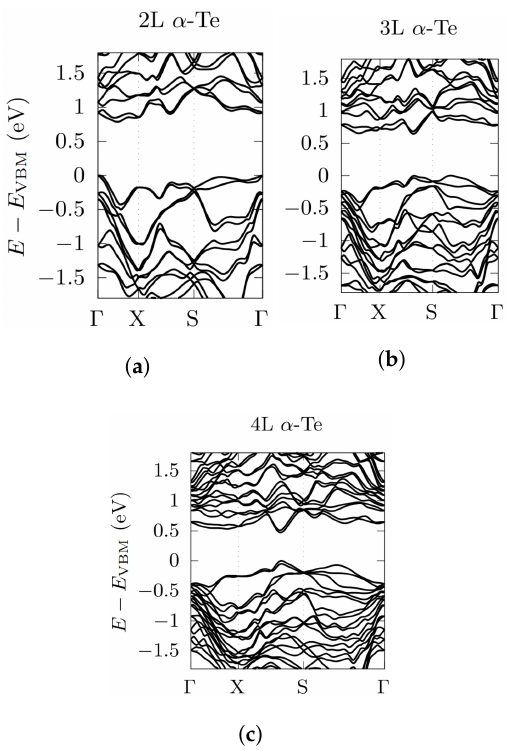
Figure 5. Electronic bandstructures, obtained by using a PBE functional, with the inclusion of SOC, for 2L γ -Te ( a ), 3L γ -Te ( b ) and 4L γ -Te ( c ). Energy rescaled with respect to the VBM (and Fermi energy for 4L). High-symmetry points related to Figure 3 (hexagonal BZ).